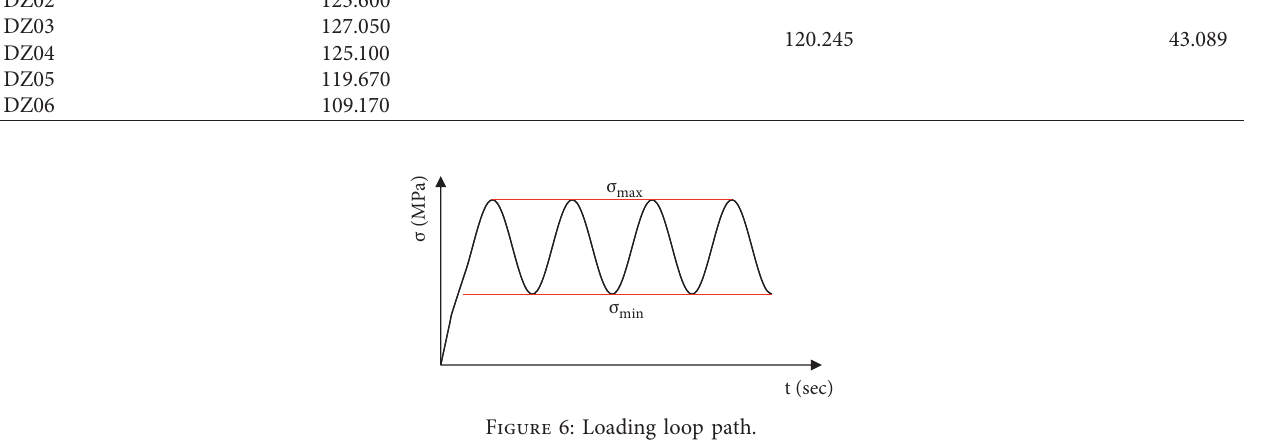
Figure 6: Loading loop path.